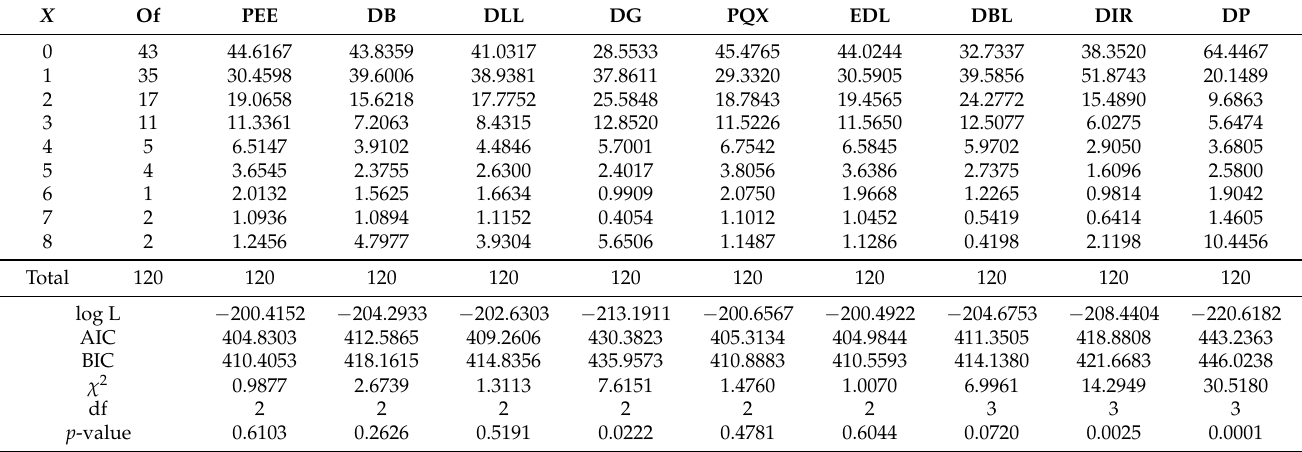
Table 9. Corn borer data: MLE, χ 2 , p -value, AIC and BIC for the competitive